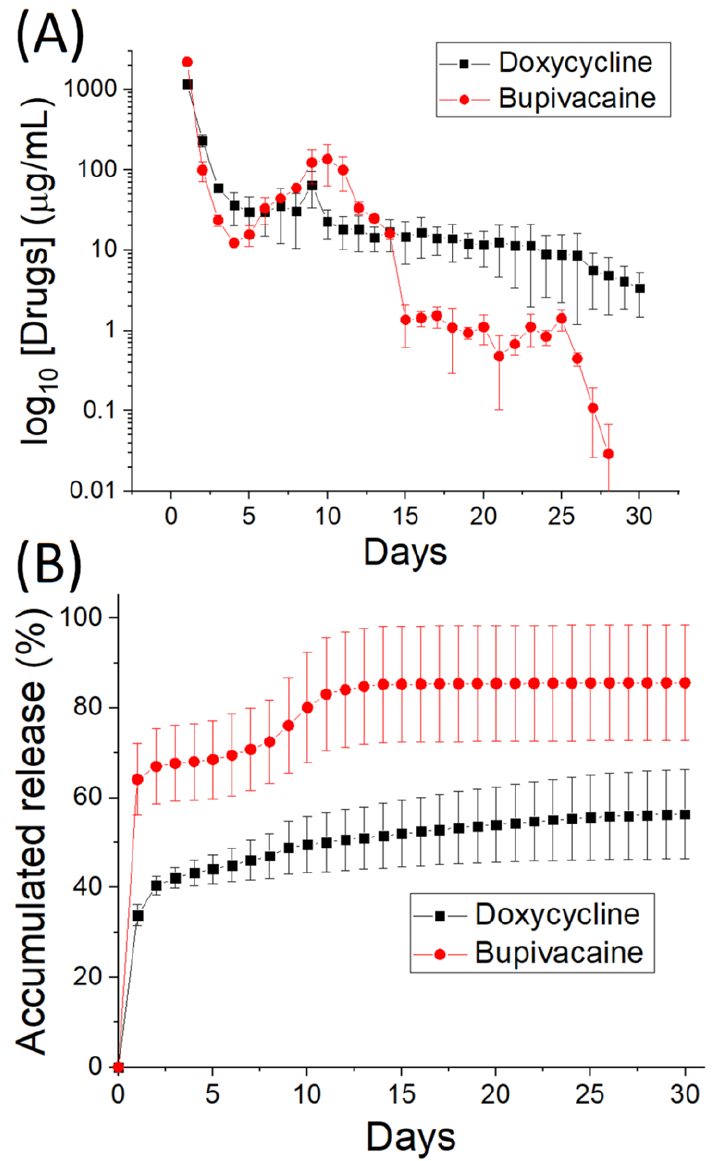
Figure 5. In vitro ( A ) daily and ( B ) cumulative release of doxycycline- and bupivacaine-loaded PLGA nanofibers.